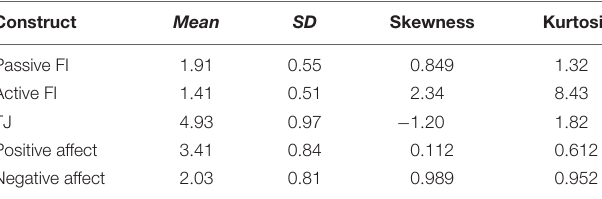
TABLE 2 | Descriptive statistics of the research